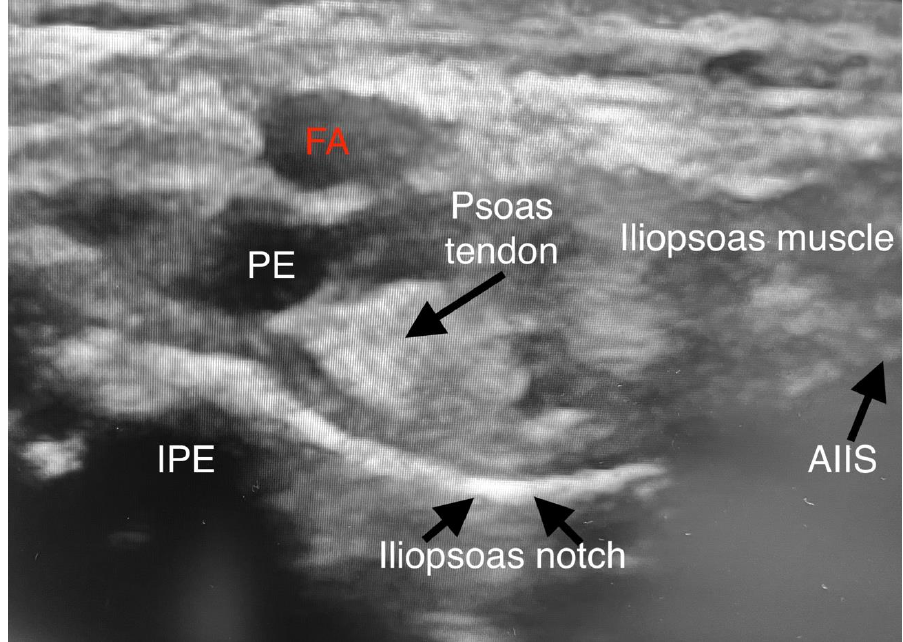
Figure 1. Sonoanatomy of PENG. (FA-femoral artery; PE — pectineus muscle; AIIS — anterior inferior iliac spine; IPE — iliopsoas prominence)